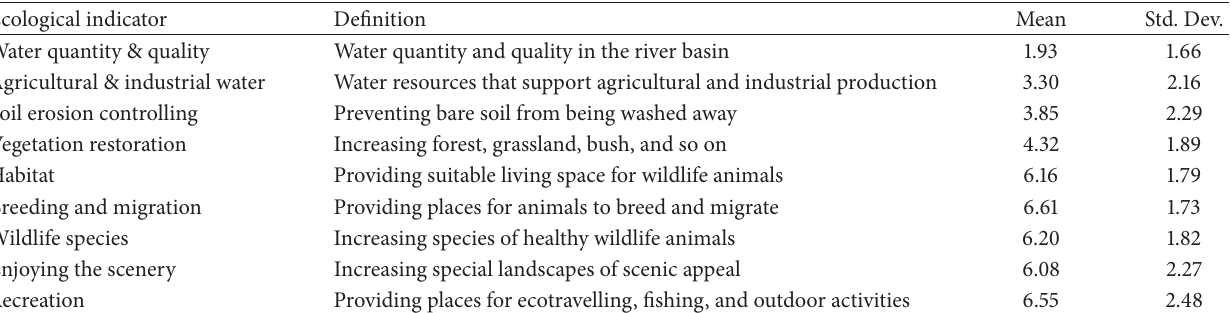
Table 5: Summary of ecological perceptions ( 𝑛 = 900 ).